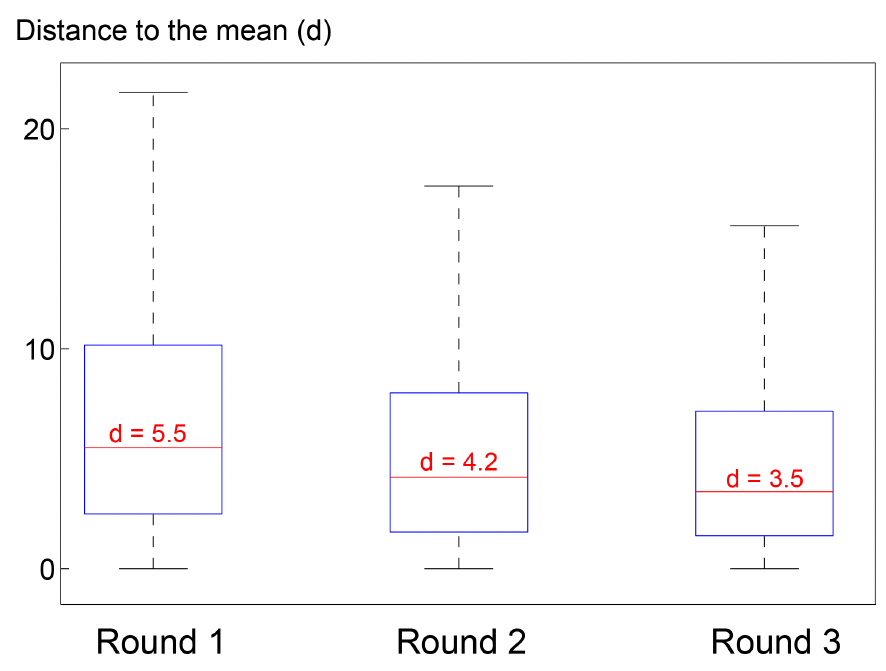
Fig 4. Distance of participants ’ judgment to mean judgment for rounds 1, 2 and 3 in the gauging game . Is displayed only the data coming from games where for all 3 rounds at least 5 out of 6 participants provided a judgment. This ensures that the judgment mean and standard deviation can be compared over